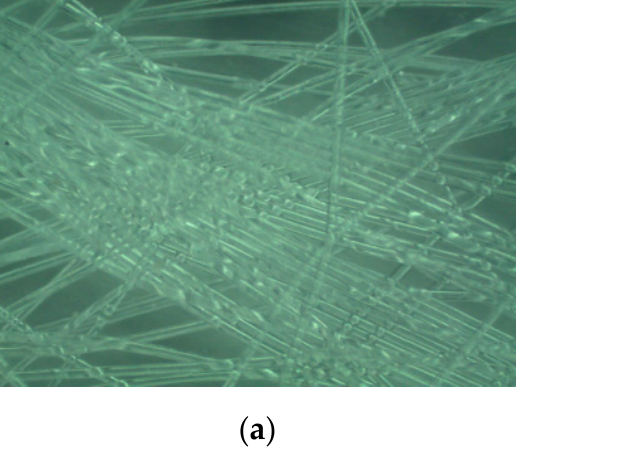
Figure 2. T he microscopic images of PE fibers. ( a ) Optical microscope image; ( b ) SEM image (SE 1500 kV ×100). Table 3 presents the GLECC mix proportions used in this study. First, by changing the FAC-to-binder mass ratio (FAC/binder: 0.15, 0.3, and 0.45), GLECC matrices were designed with three densities. Then, PE fibers of different volume fractions ( V f ) were